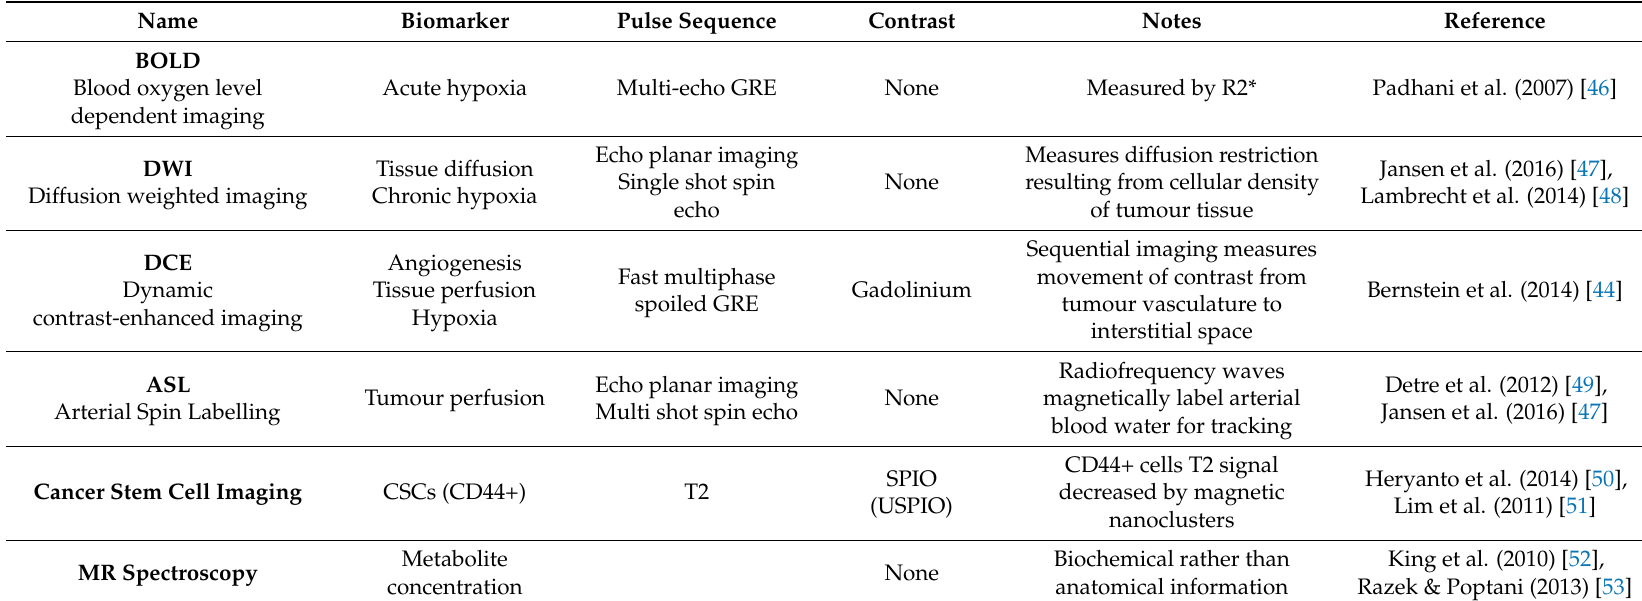
Table 3. MRI imaging techniques for biomarkers in